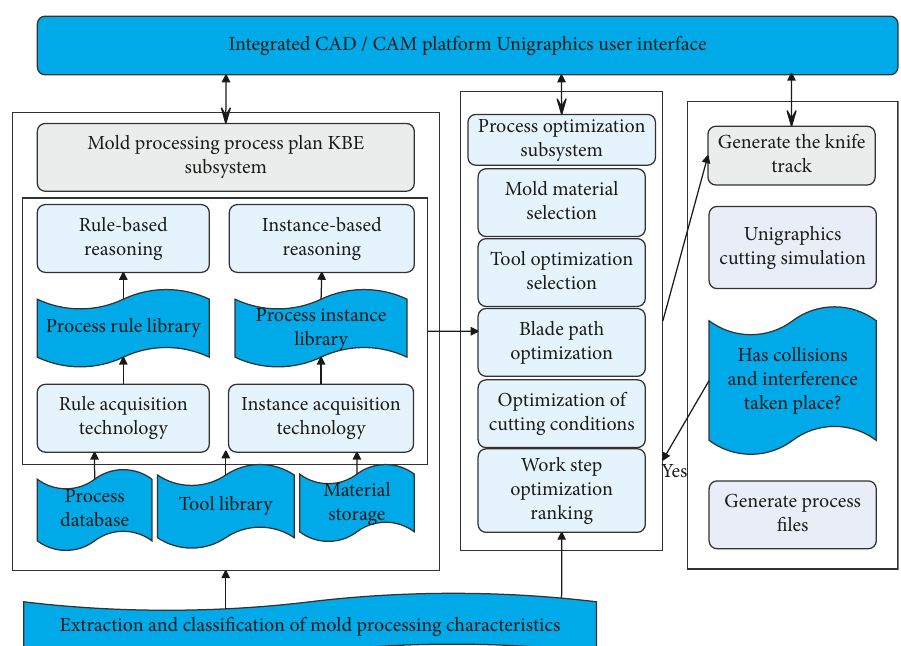
Figure 11: CNC machining method based on CAD/CAM/Robot